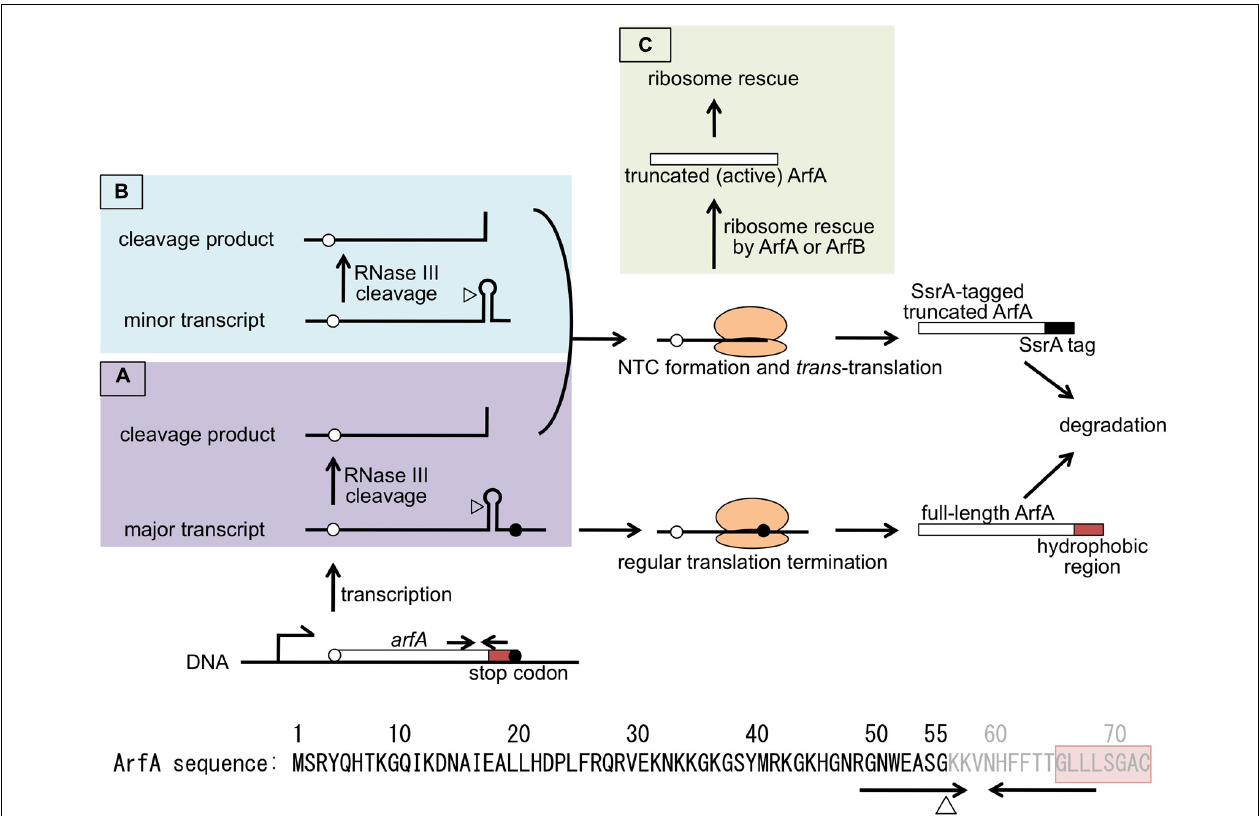
FIGURE 2 | Modelfor trans -translation-mediatedregulationofArfA expression. arfA istranscribedasmRNAwith (A) orwithout (B) stopcodon.In bothcases,mRNAiscleavedbyRNaseIIIatthesiteindicatedbytriangle.This resultsinthenon-stopmRNAformation.ArfAtranslatedfrom arfA